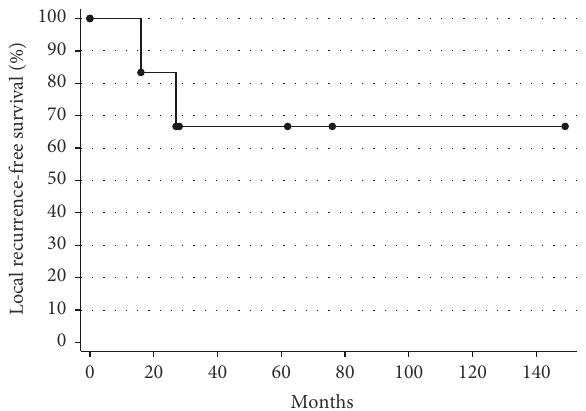
Figure 3: Local recurrence-free survival curve. Kaplan-Meier curve for local recurrence-free